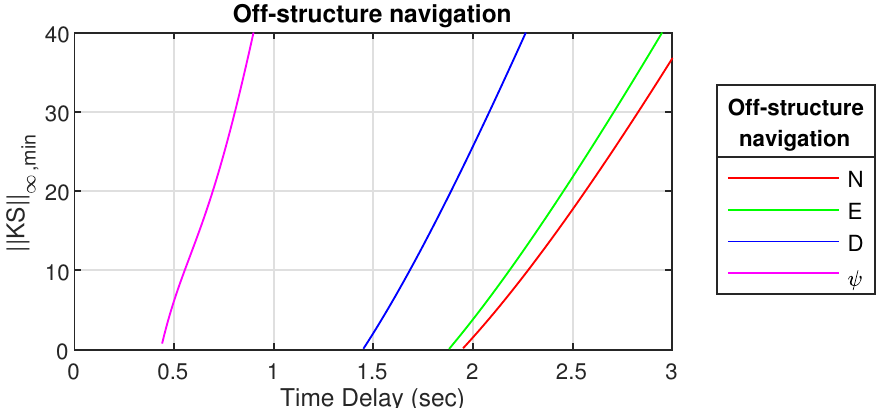
Figure 15. (cid:107) KS (cid:107) ∞ , min for near-structure operation.